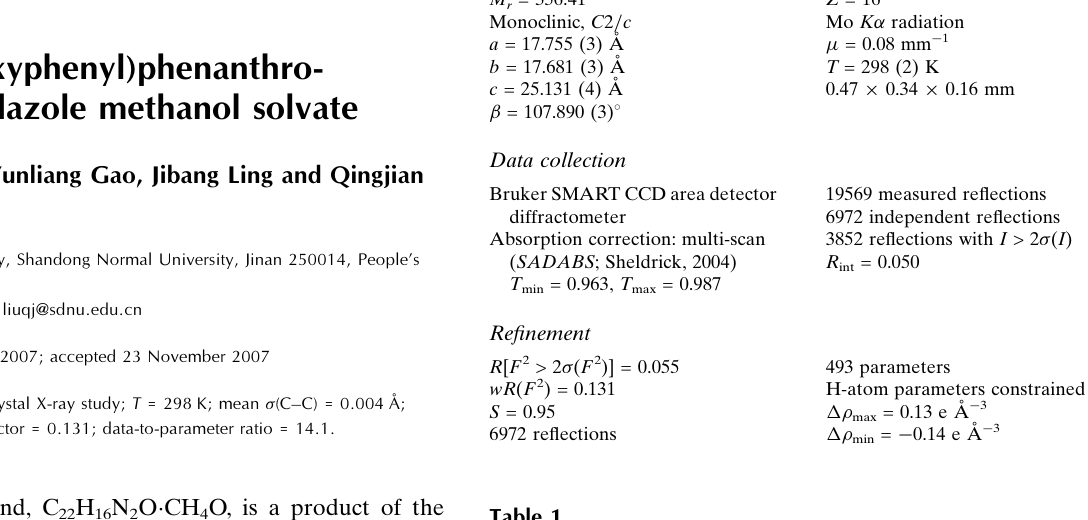
Hydrogen-bond geometry (A˚ , (cid:2)